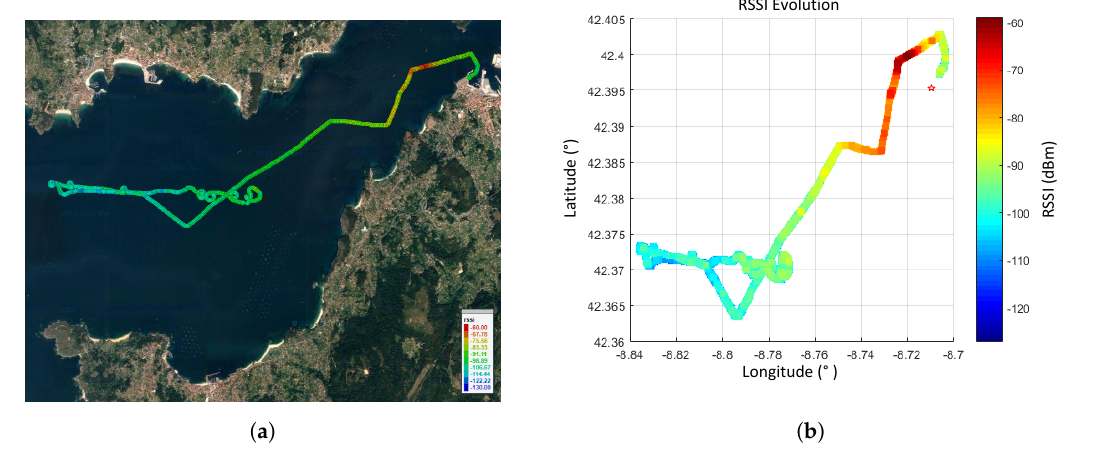
Figure 25. RSSI measurement trial: ( a ) Ría de Pontevedra scenario. ( b ) RSSI values